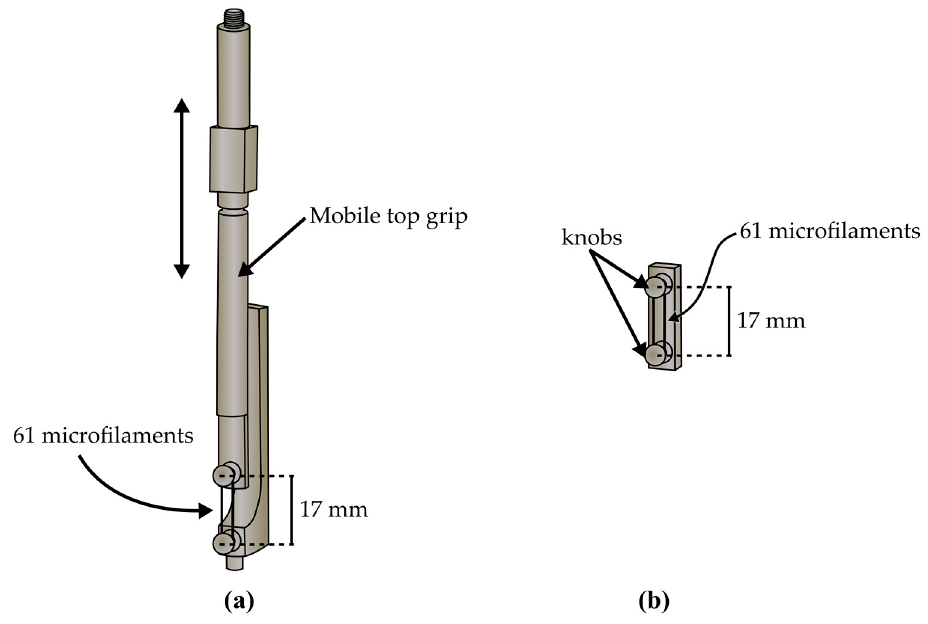
Figure 2. Diagram of grips with microfilament scaffolds. ( a ) shows the mobile grip system and ( b ) shows the control grip.